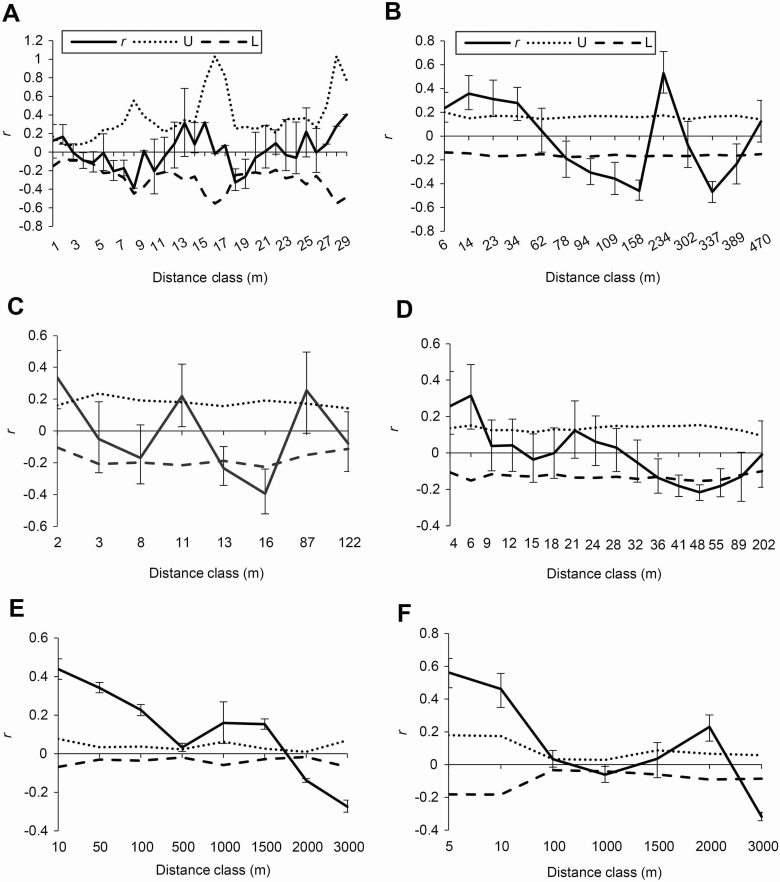
Correlogram showing the spatial autocorrelation coefficient (r) within subpopulations in metapopulations of Zingiber corallinum and Z. nudicarpum. U and L represent the 95 % two-tailed confidence interval, which was calculated based on 999 permutations; (A–D) subpopulations 1–4 in the GDYX metapopulation of Z. corallinum; (E and F) subpopulations 1–2 in the HNCJ metapopulation of Z. nudicarpum.